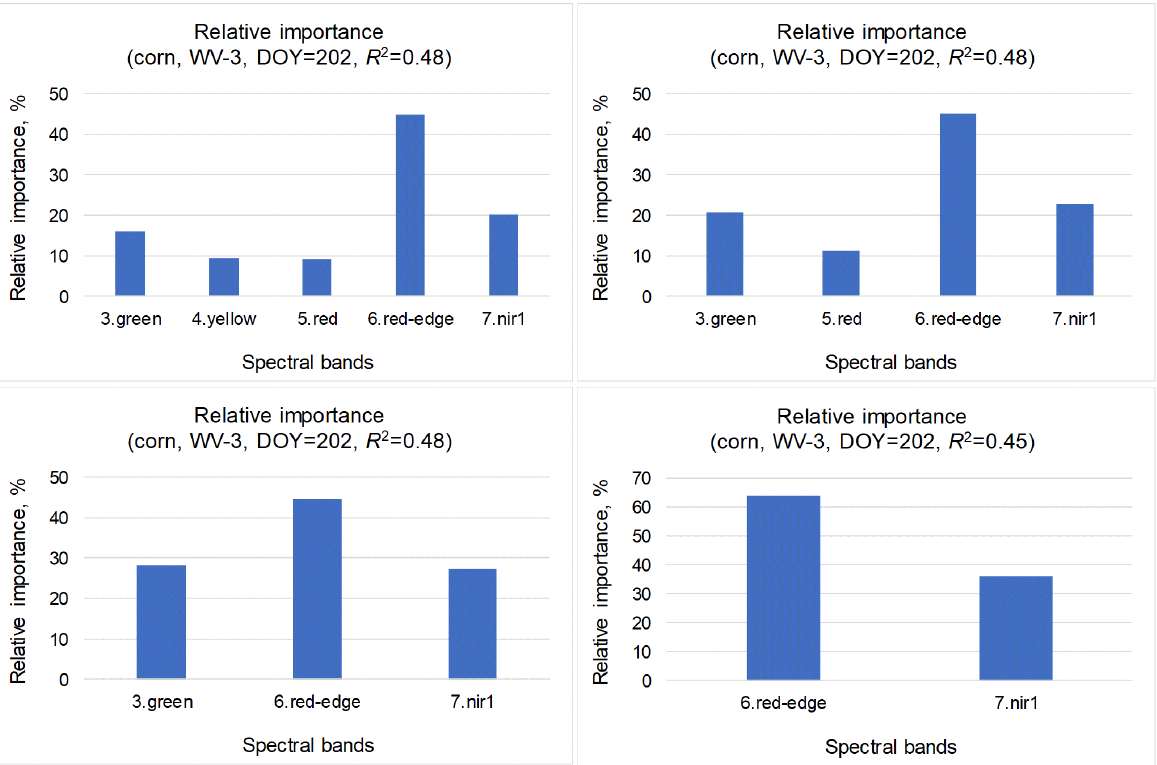
Figure 8. Relative importance of WV-3 spectral bands when correlating them with corn yields. WV-3 was acquired on 21 July 2018. Shown also is R 2 for the linear model between SR values and corn yields.